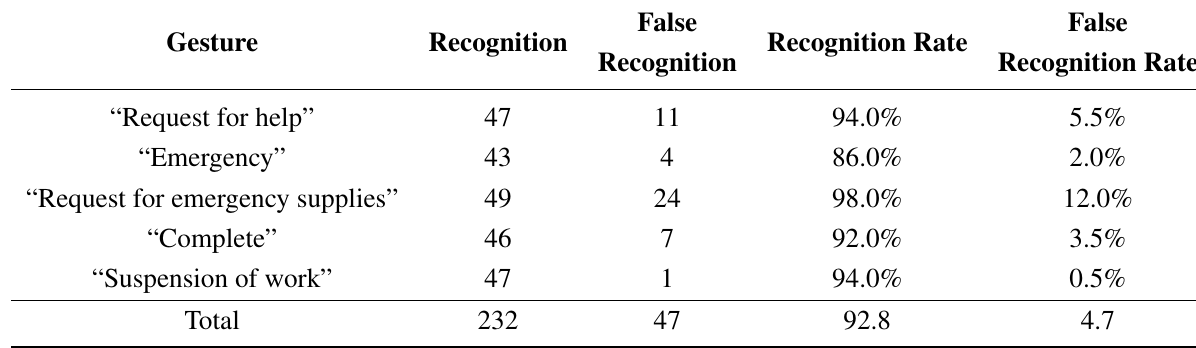
Table 5. Experimental results of gesture recognition.